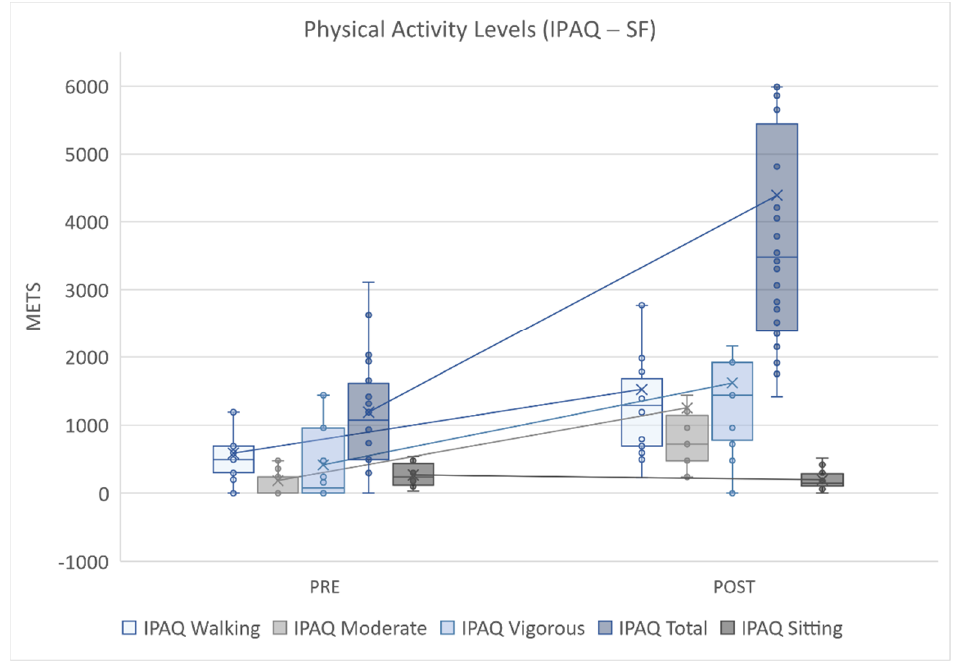
Figure 1. Physical activity levels (IPAQ-SF); PRE = pretest; POST = posttest; METS = metabolic equivalents.